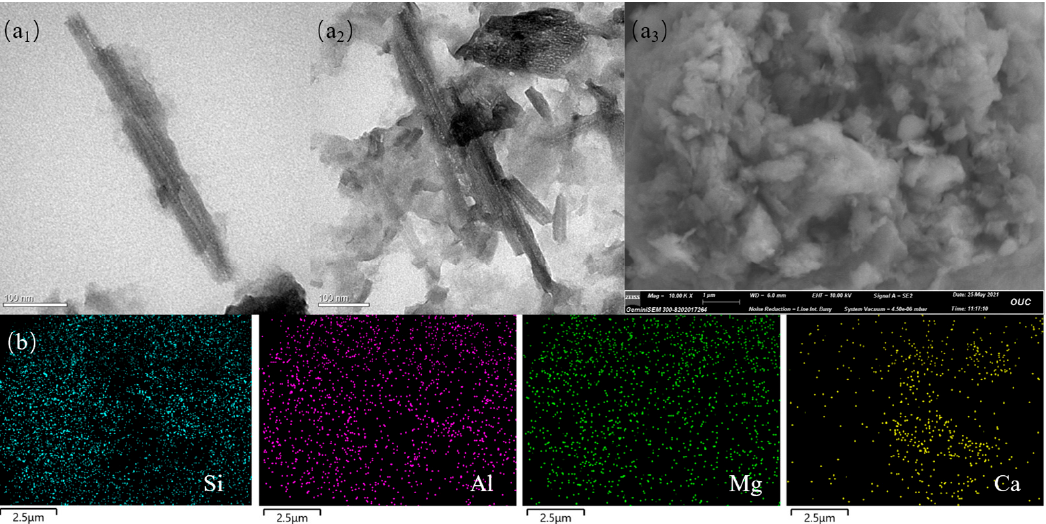
Figure 1. TEM ( a1 , a2 ) and SEM ( a3 ) and elements mapping ( b ) of SO 3 H-APG catalyst of ( a3 ).